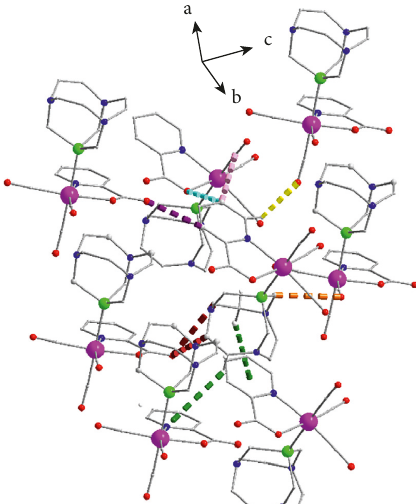
Figure 5: Intermolecular interactions among neighboring clusters in the structure of compound 2b . The different type of hydrogen bond interactions is indicated with dashed thick orange (C 12 -H 12 cyan (C 8 -H 8 O 4 ) dashed lines. The pink dashed lines indicate carbonyl C 8 -H 8 ·· · π type of interactions) are indicated with violet, yellow, and dark green dashed lines, respectively. H 16 ∙∙∙ Cg 2 (C-H ·· ·